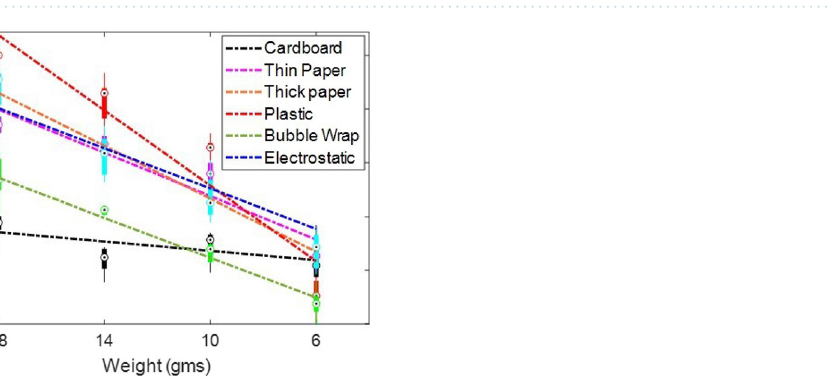
Figure 13. Comparison of different package types investigated in this paper along with their cross-sectional thickness: ( a ) cardboard, ( b ) bubble wrap, ( c ) polyethylene, ( d ) thin paper envelope, ( e ) thick paper envelope, and ( f ) electrostatic discharge (ESD)-protected packaging.